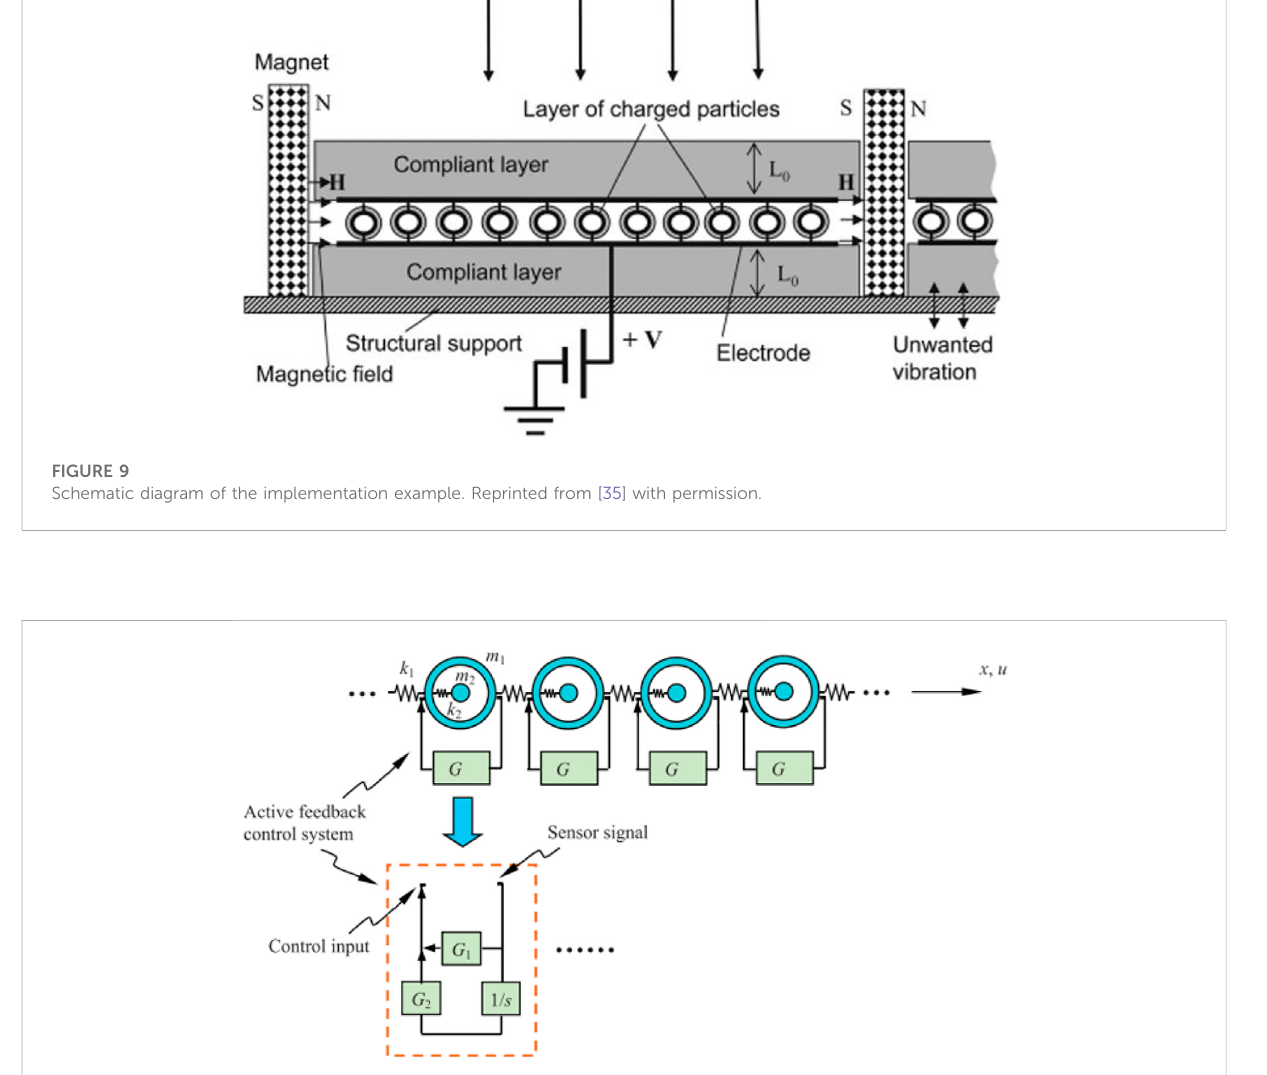
Figure 10. The propagation properties of elastic waves are discussed.